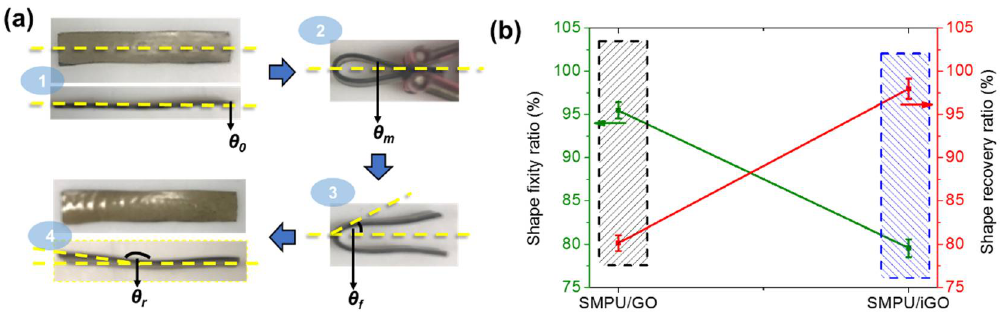
Figure 4. Shape-memory e ff ects of SMPU / GO and SMPU / iGO: ( a ) Bending test—( 1 ) original angle ( θ 0 = 0), ( 2 ) temporary angle ( θ m = 1800), ( 3 ) fixed angle (θ r ), and ( 4 ) recovered angle (θ r ); ( b ) Shape fixity ratios and recovery ratios.